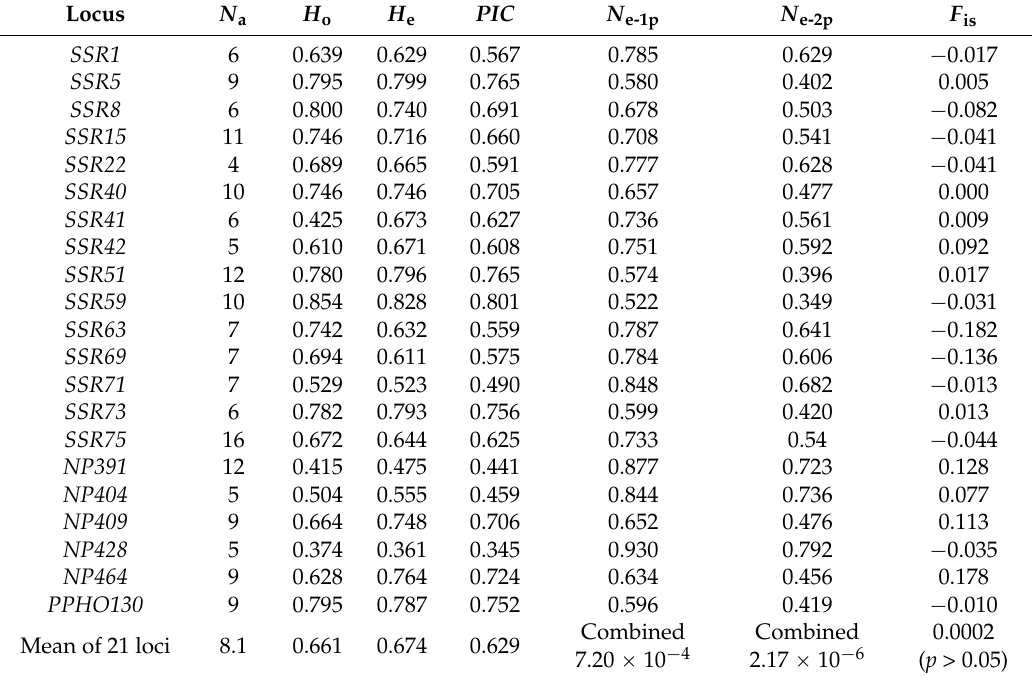
Table 1. Characteristics of genetic diversity at 21 microsatellite loci for 122 Yangtze finless porpoises in the Poyang